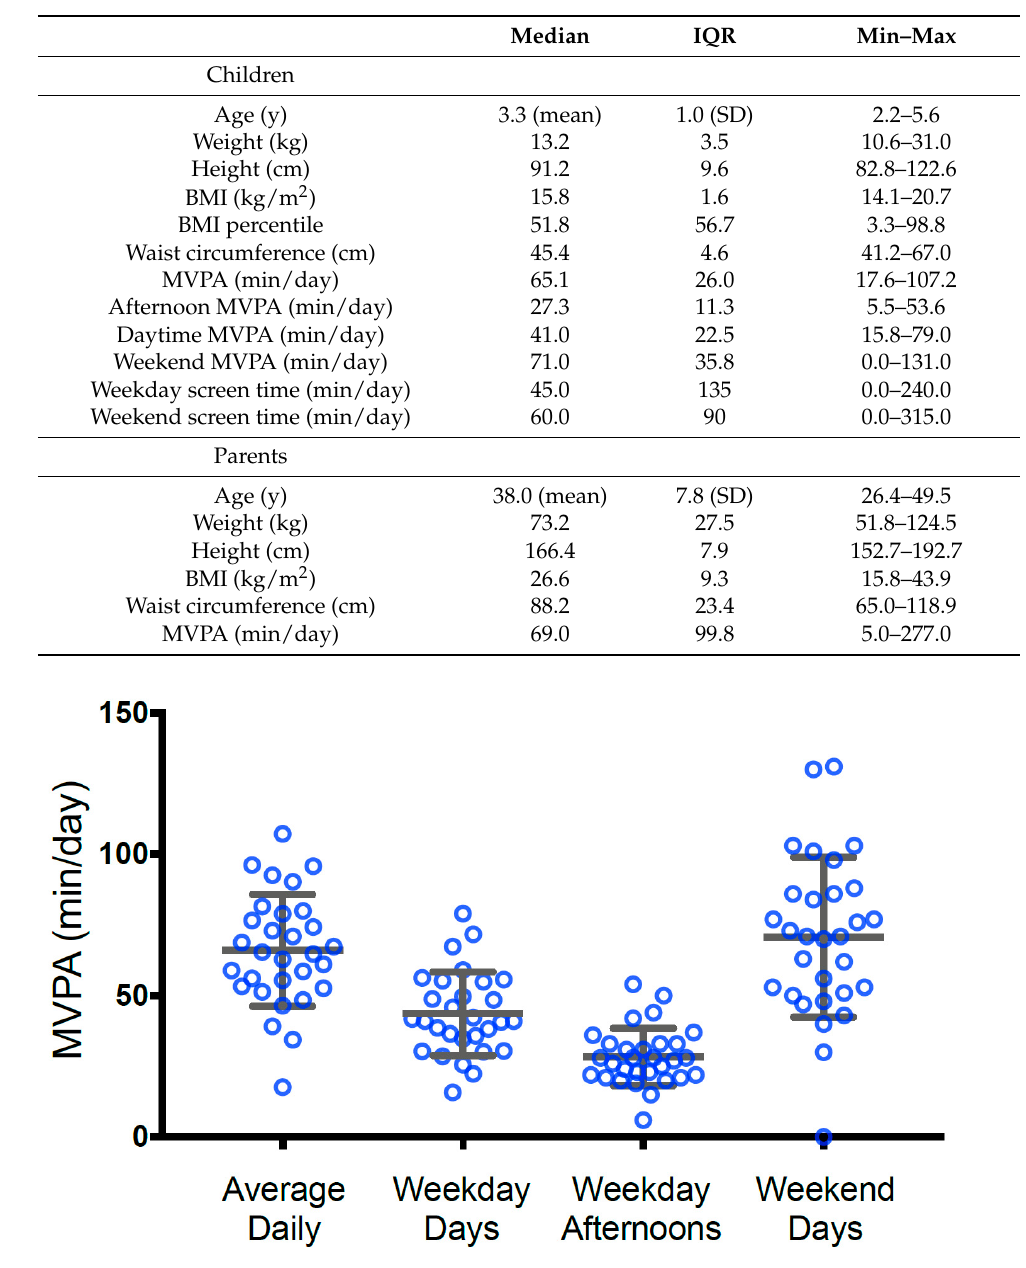
Figure 1. Child physical activity as measured by ankle-worn accelerometer. Values are expressed in min/day and represent the average weekly MVPA, average MVPA on weekday days (except 3:00–8:00 p.m.), average MVPA on weekday afternoons (3:00–8:00 p.m.), and average MVPA on weekend days. Table 2. Frequency of parent responses to Pre-PAQ questions about PA encouragement and modeling and the extent to which their work limits time with their